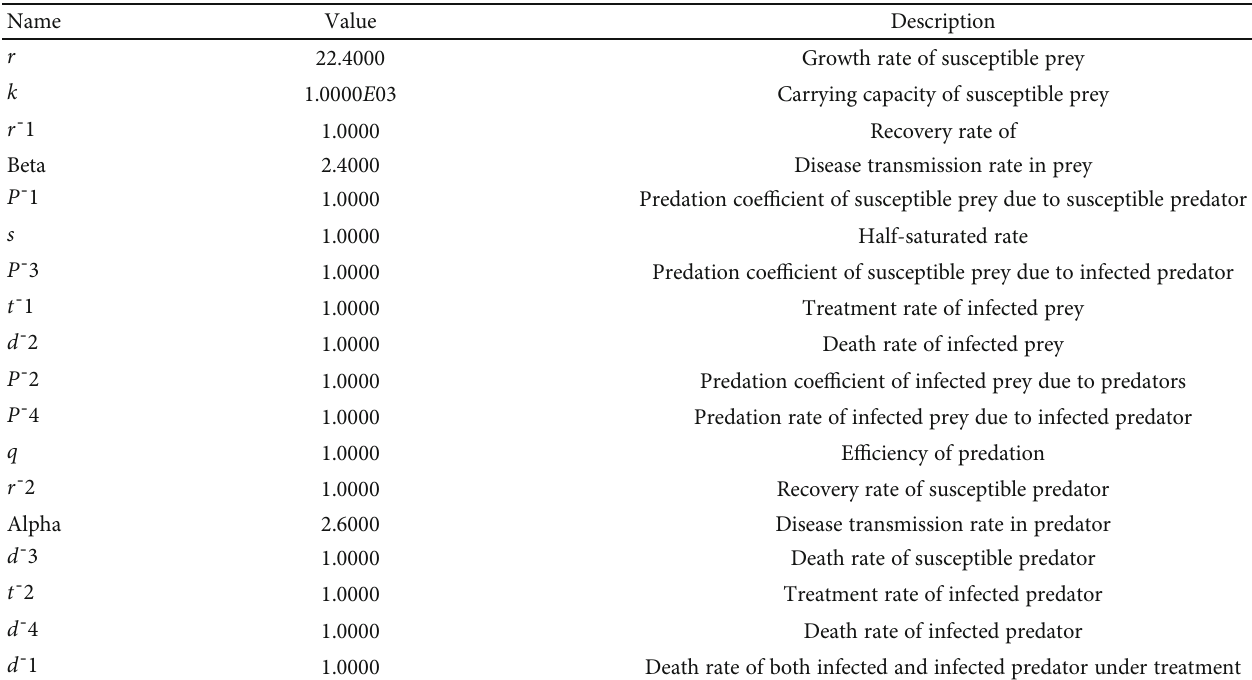
Table 4: Parameter value used in simulation.